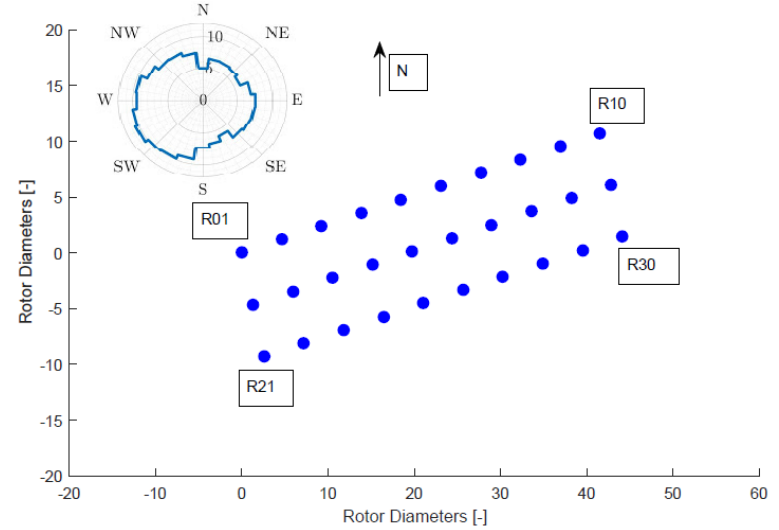
Figure 1. Layout of the Riffgat wind farm. The wind rose is computed from Supervisory Control and Data Acquisition (SCADA) data of the years 2014 and